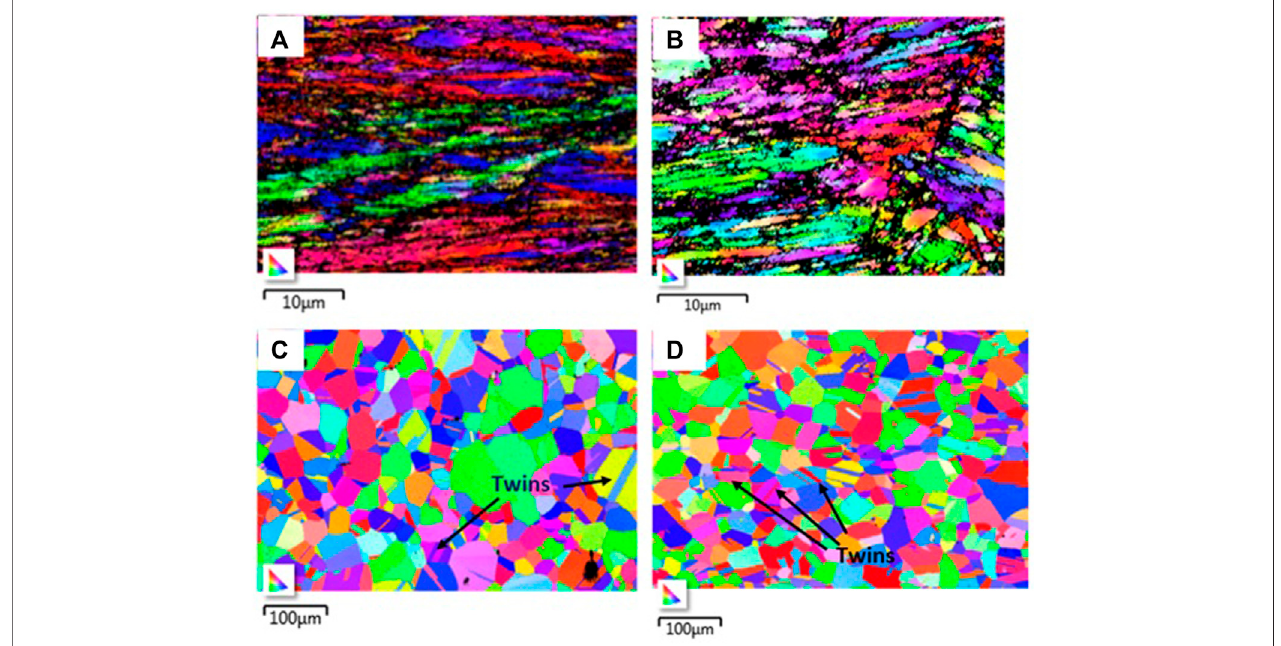
FIGURE 3 | EBSD maps of CR1 (A) , CR2 (B) , HT1 (C) and HT2 (D) . The EBSD maps of the cold rolled samples show the elongated grain structure. The dark regions in the EBSD maps indicate the localization of plastic deformation. The twins are evident in the heat-treated samples. Some of them are shown with the arrow.